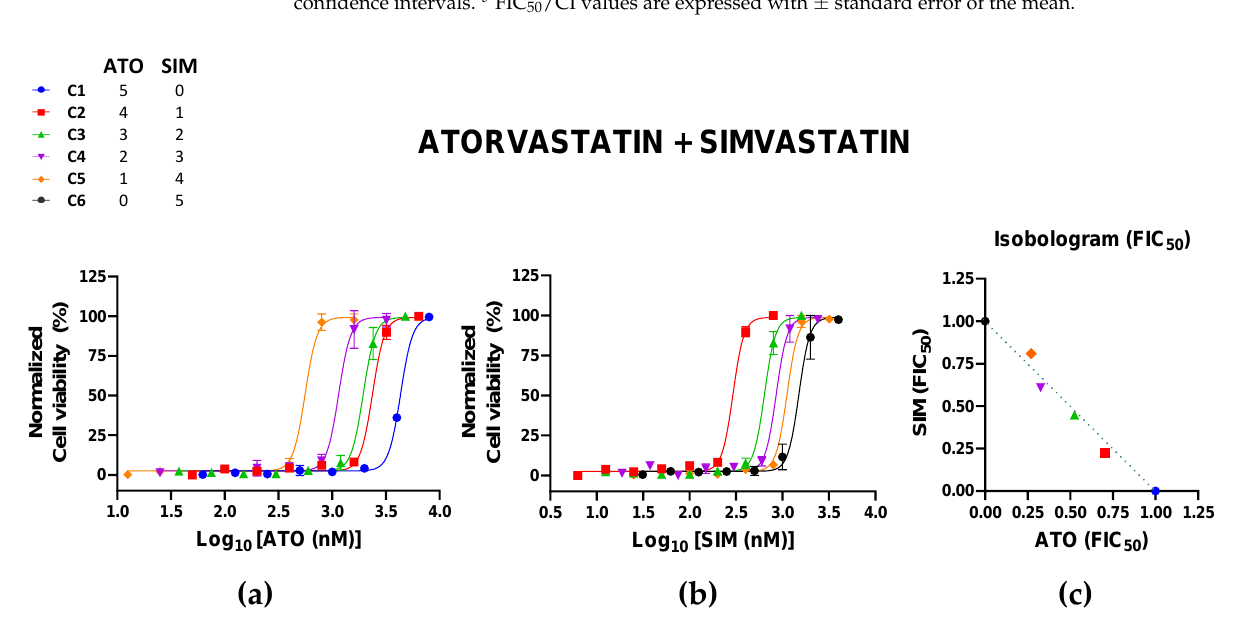
Figure 2. Effects of the combination of atorvastatin (ATO) and simvastatin (SIM) on Zika virus (ZIKV) infection. Vero cells were infected with ZIKV (MOI of 0.02) and treated with different combinations of ATO and SIM. Normalized cell viability of ZIKV-infected cells in response to the different concentrations of ( a ) ATO and ( b ) SIM in their different combinations are shown. All datapoints represent the mean ± SEM of 2 independent experiments per combination. ( c ) The normalized isobologram was constructed based on the mean FIC 50 of each statin (Table 2). Colors and symbols in the legend correspond to those in ( a – c